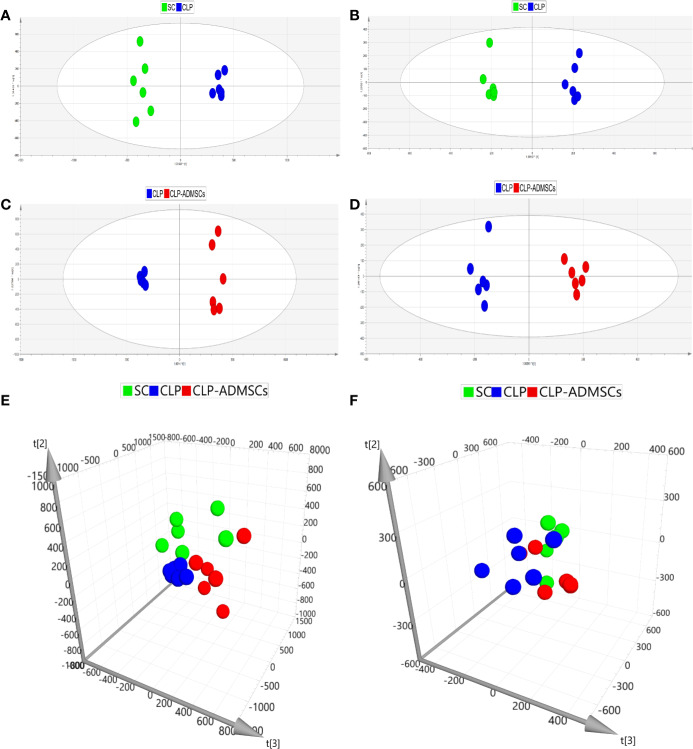
PCA and OPLS-DA scores of plasma samples (n = 6). (A, C, E) Positive ion mode. (B, D, F) Negative ion mode.